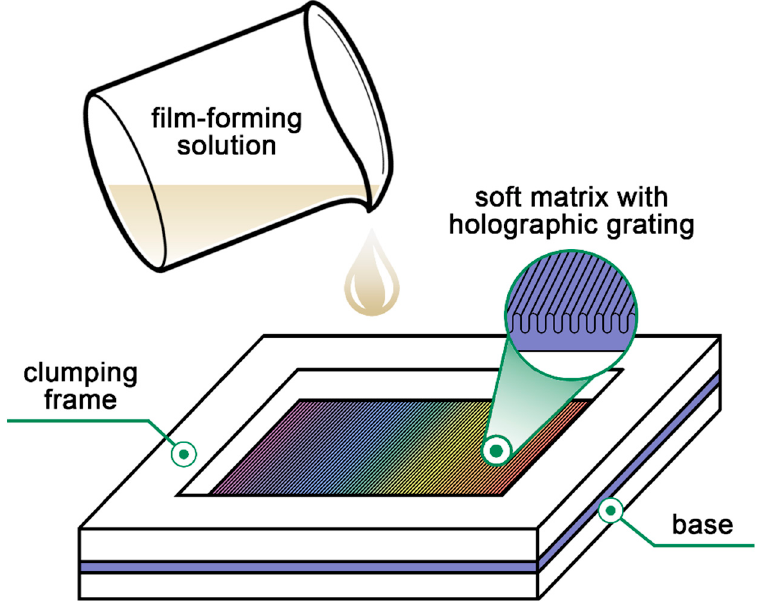
Figure 1. Scheme of the casting mold for the film-forming solution.